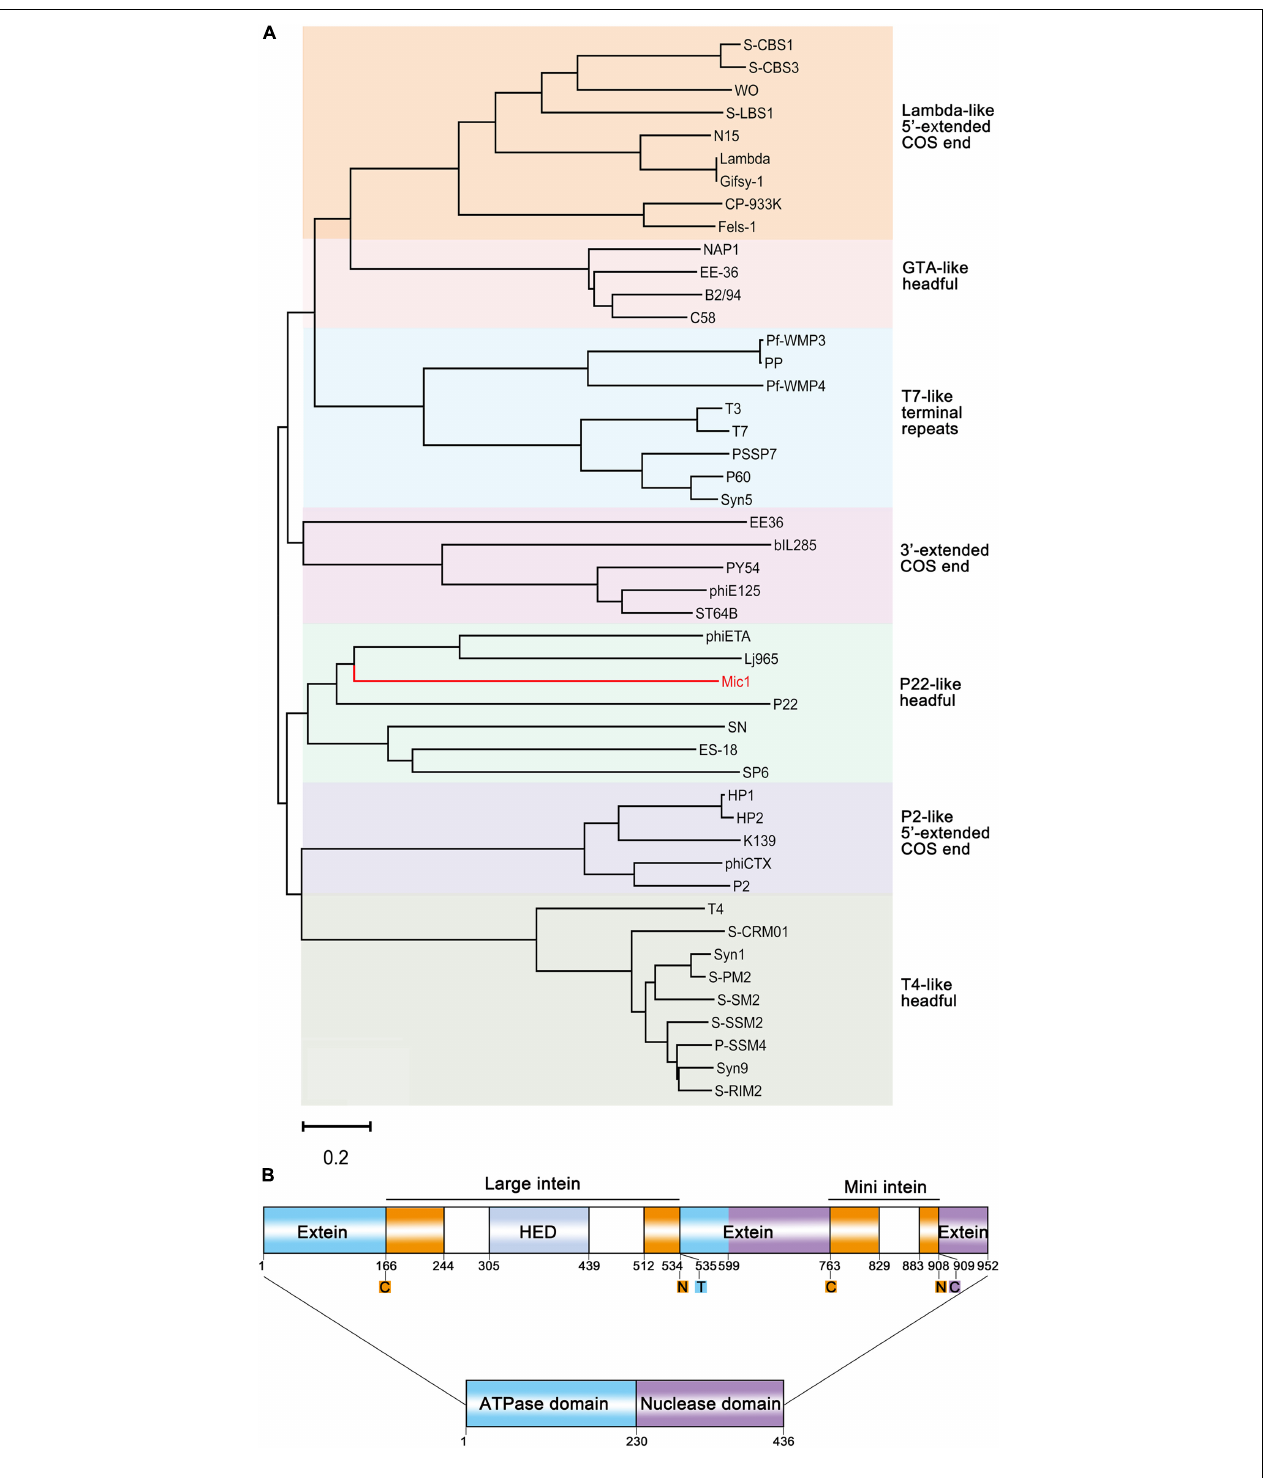
FIGURE 4 | Analyses of Mic1 TerL. (A) Phylogenetic tree of TerL proteins from different phages inferred by Neighbor Joining. Colored boxes indicate the characterized clusters which have similar DNA ends. The sequences, except that of Mic1, were classified as described previously (Casjens and Gilcrease, 2009; Huang et al., 2012), and bootstrap analysis was performed with 1,000 repetitions. The scale bar represents 0.2 changes per amino acid. (B) Domain organization of TerL. ATPase domain and nuclease domain are indicated by blue and purple box, respectively. The termini of intein are indicated by orange boxes, and the homing endonuclease domain (HED) in the large intein is indicated by the light gray box. Color blocks indicate the conserved amino acid residues at split sites, the oranges (cysteine, asparagine) for the boundary of intein, the blue (threonine) and purple (cysteine) for the boundary of extein.